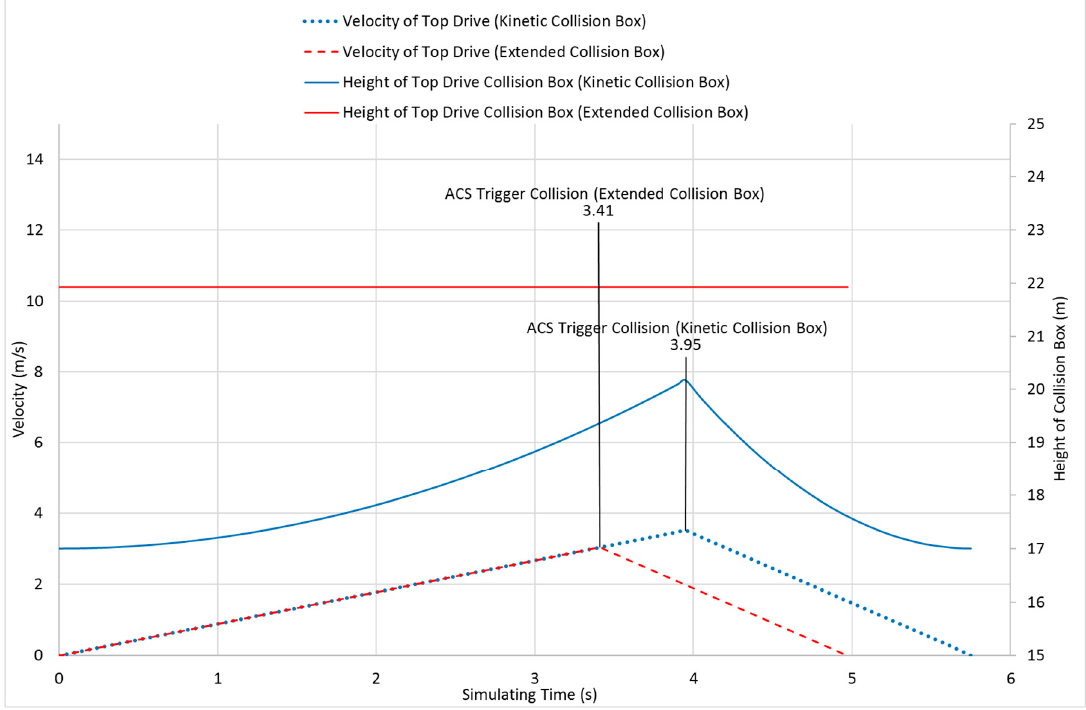
Figure 17. Scale of the Collision Box using the kinematic collision box algorithm and the extended collision box. collision